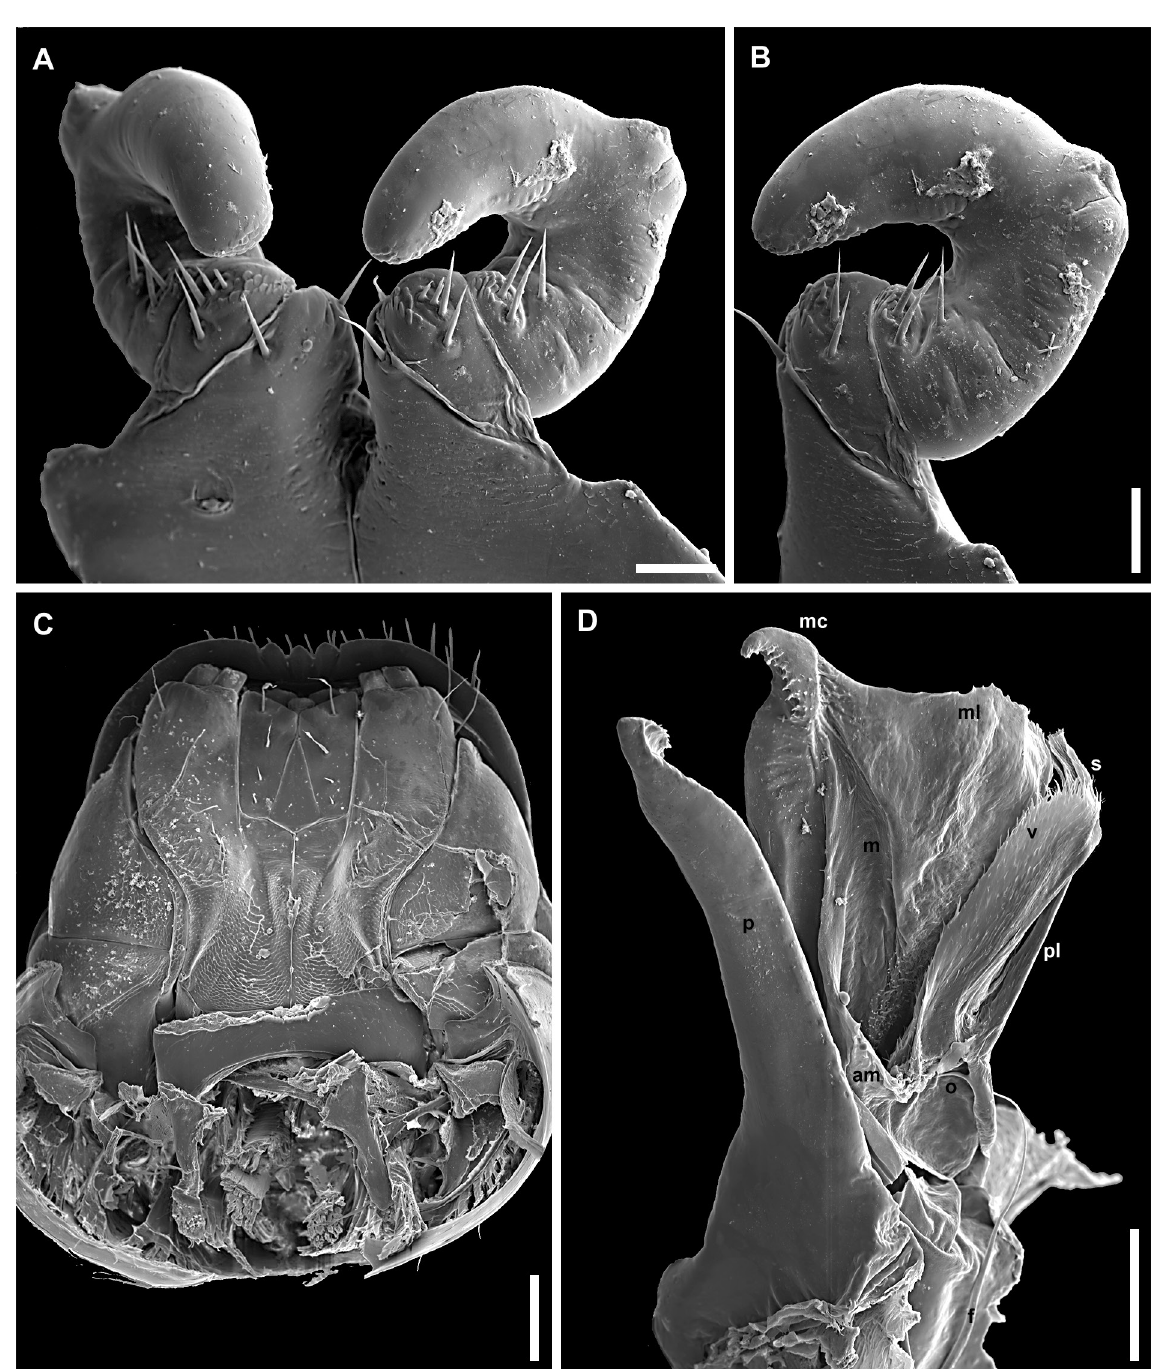
Fig. 17. Leucogeorgia borealis sp. nov., paratype ♂ from Fanagoriyskaya Cave (ZMUM). A . Leg-pair 1, anterior view. B . Right leg 1, lateral view. C . Head, ventral view. D . Left gonopods, mesal view. Abbreviations: am = accessory membrane; f = flagellum; m = mesomere; mc = mesomeral claw; ml = mesomeral lamella; o = opisthomere; p = promere; pl = protective lamella; s = solenomere; v = velum. Scale bars: A–B = 0.05 mm; C = 0.2 mm; D = 0.1